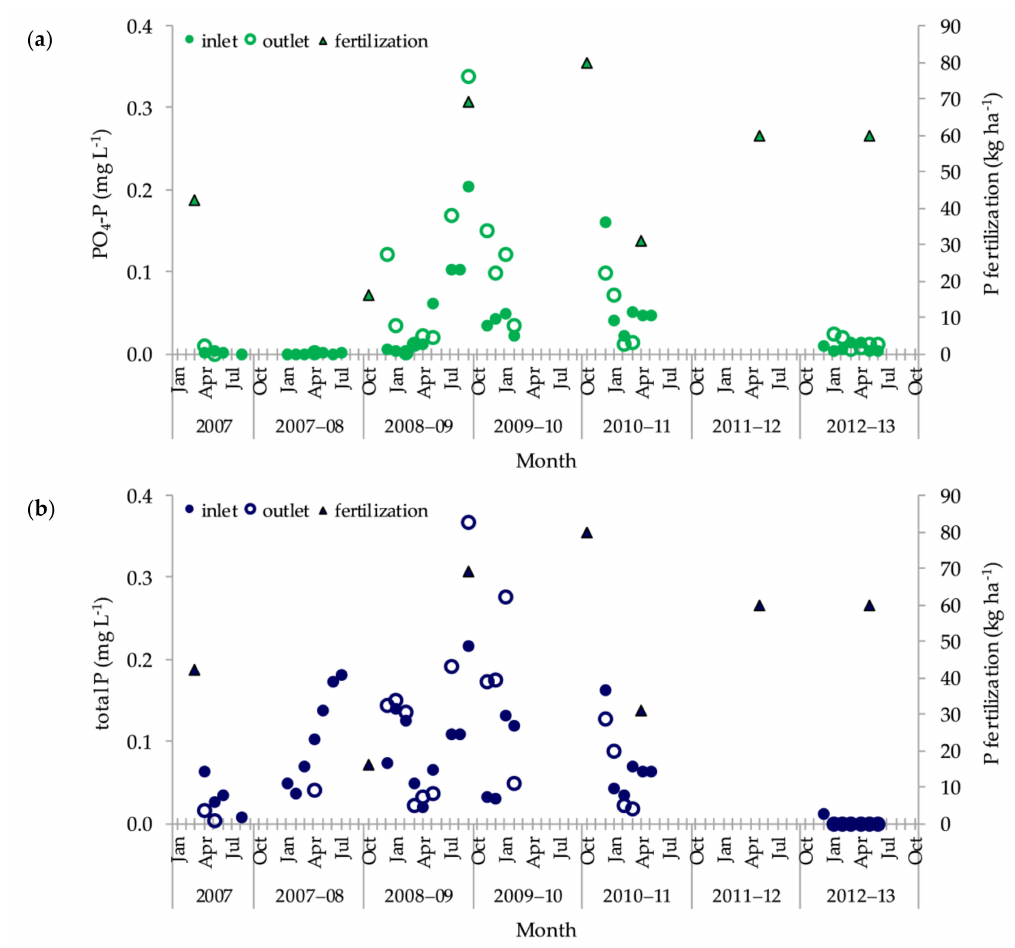
Figure 5. PO 4 –P ( a ) and total P ( b ) monthly flow-weighted inlet and outlet concentrations. P fertilizer applications are